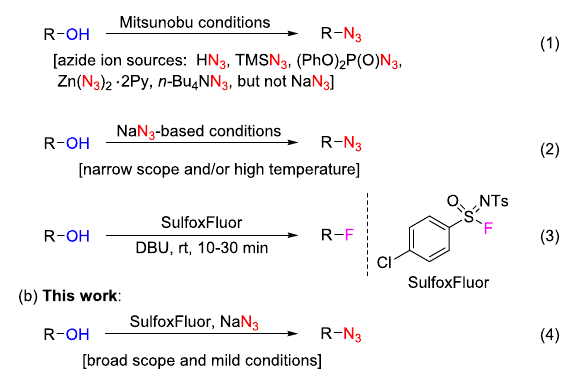
Fig. 1 Deoxyazidation of alcohols. a Illustration of previous work on deoxyazidation of alcohols (Eqs 1 – 2) and deoxy fl uorination of alcohols with SulfoxFluor (Eq 3). b Illustration of this work. Eq 4 refers to the SulfoxFluor- mediated deoxyazidation of alcohols with NaN 3 . Eqs 1 – 3 refer to the previously reported deoxyazidation of alcohols (previous work), and eq 4 shows the SulfoxFluor-mediated deoxyazidation of alcohols with NaN 3 (this